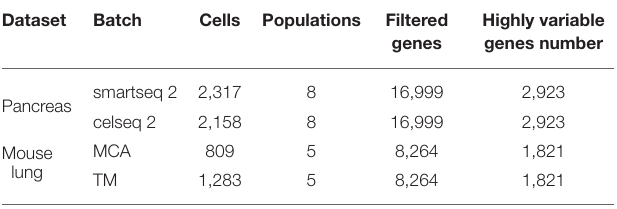
TABLE 1 | Cell type information of the utilized scRNA-seq